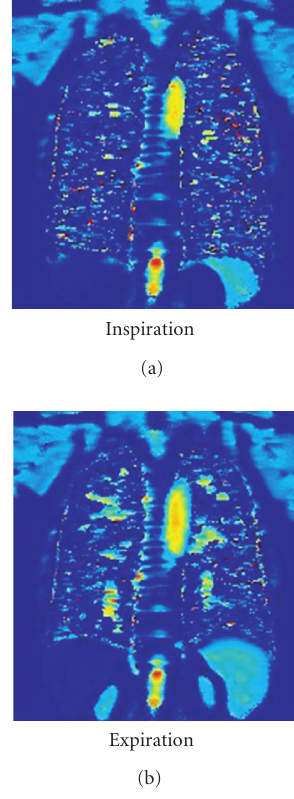
Figure 5: T1 map of a patient with lung emphysema: when com- pared to a healthy lung (Ill. 1), the T1 time is clearly shortened. Expiration (b) demonstrates no significant prolongation of the T1 time as compared with inspiration